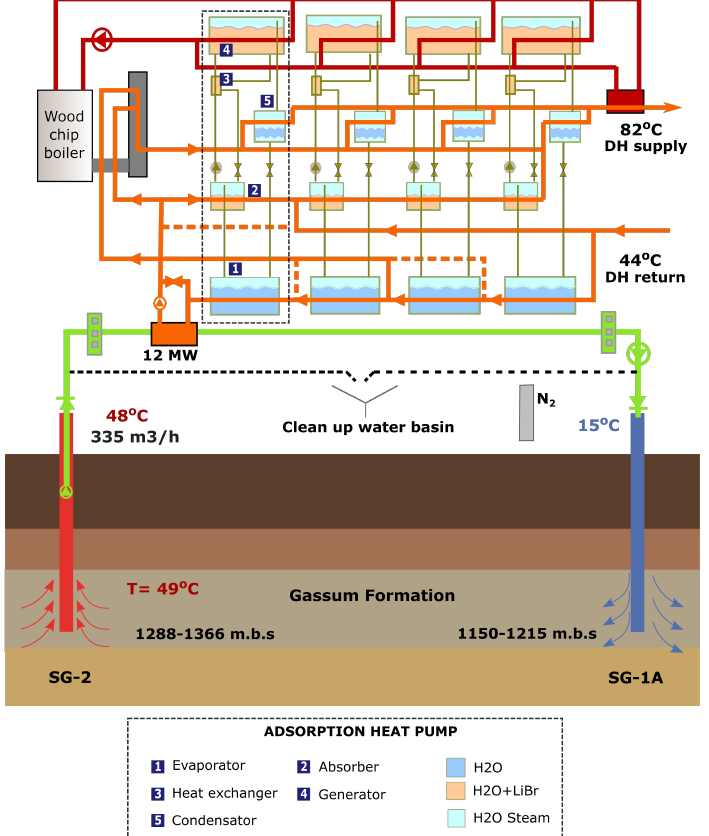
Figure 3. Conceptual sketch. The overall design was built around a geothermal circuit (green), district heating circuit (orange), and drive heating circuit